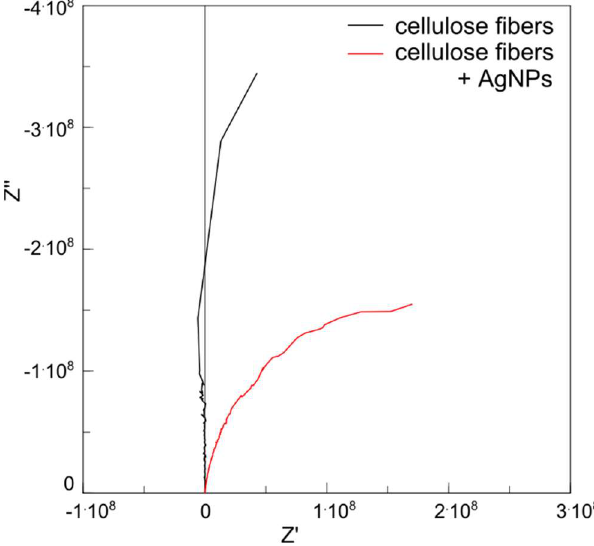
Figure 13. Impedance spectroscopy measurement of cellulose fibers.